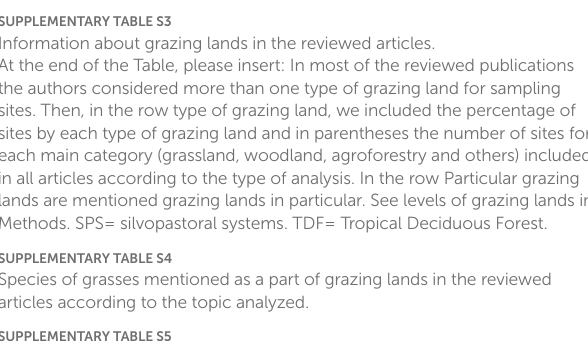
SUPPLEMENTARY TABLE S5 (A) Percentage of studies with information on livestock management. (B) Percentage of studies with information on management practices. SUPPLEMENTARY BOX I Data collection format for ecological pasture